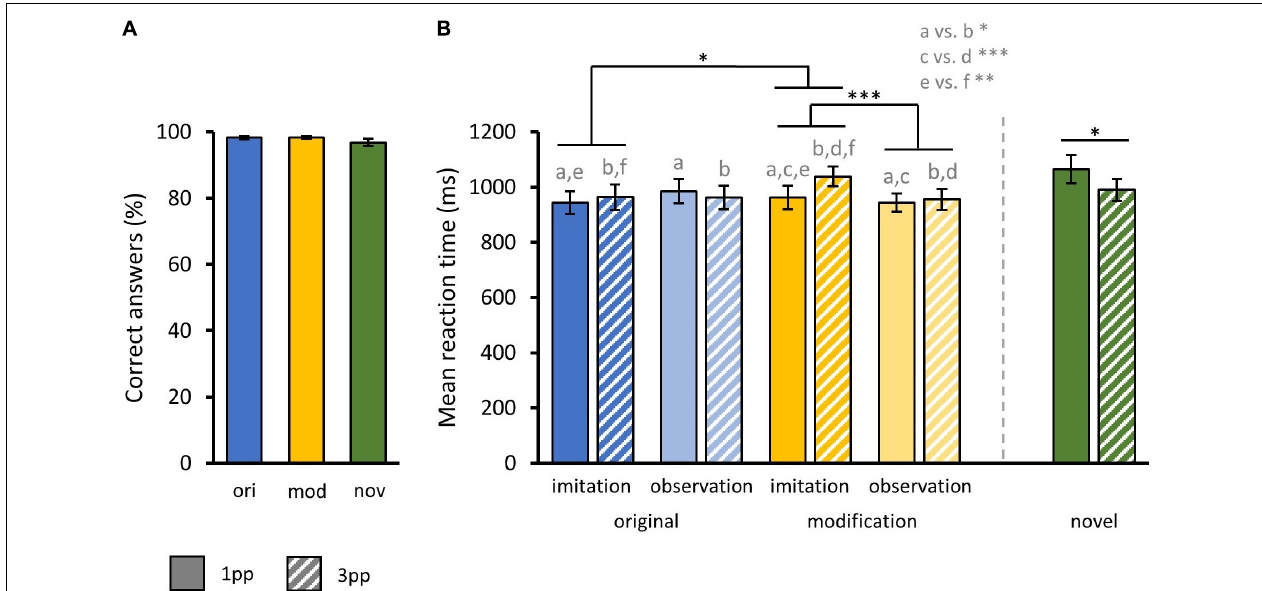
FIGURE 5 | Behavioral results from fMRI task. (A) Mean correct response rates for original (ori), modified (mod), and novel (nov) videos during fMRI action recognition task. (B) Mean reaction times for original and modified videos separated by the factors AGENCY (imitation, observation) and PERSPECTIVE (1pp, 3pp) and additionally for novels. Statistics: rmANOVA with post hoc paired t -tests; a vs. b = p < 0.05; c vs. d = p < 0.001; e vs. f = p < 0.01. (A,B) Bar charts show means and standard errors.